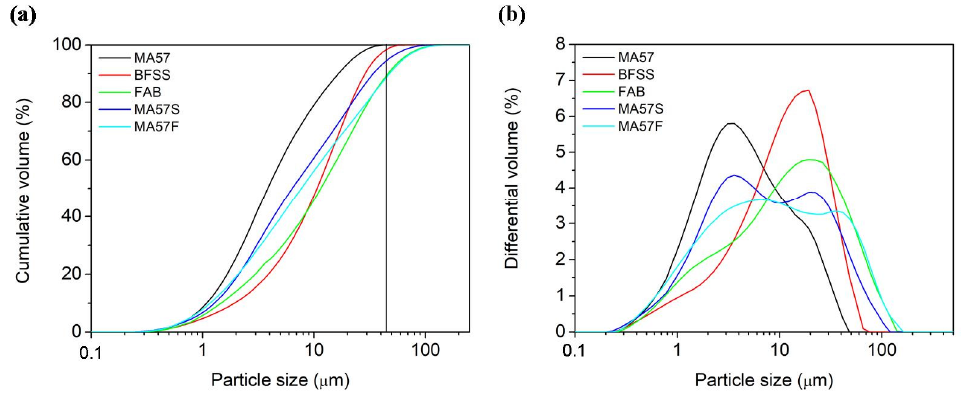
Figure 1. ( a ) Cumulative percentage volumes and ( b ) grain-size distributions of raw materials (MA57, BFSS and FAB) and binary blends (MA57S and MA57F).